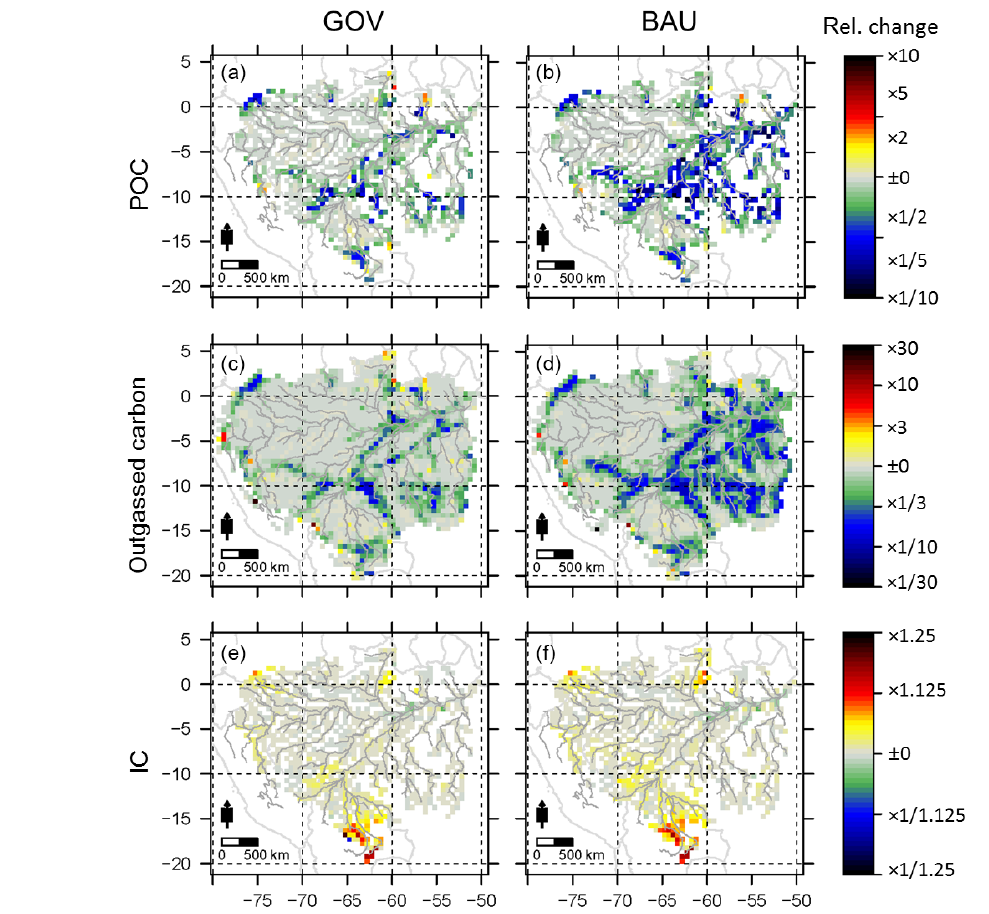
Figure 3. Change in carbon caused by deforestation. Climate model mean ( E Defor ) of the change of particulate organic carbon POC (a, b) , outgassed carbon (c, d) and inorganic carbon IC (e, f) . Results of the SRES emission scenario A1B are averaged over five climate models. Areas in yellow and red indicate a gain, and areas in green and blue indicate a loss in carbon caused by deforestation (GOV and BAU). White areas within the Amazon basin represent cells where changes are not significant ( p value >